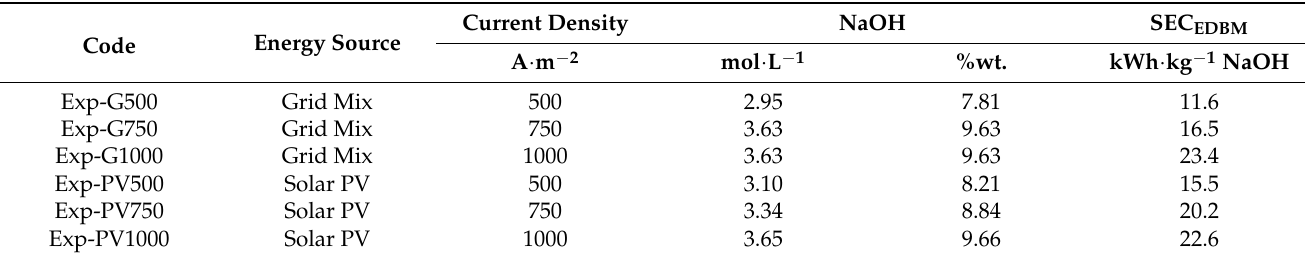
Table 1. Summary of the maximum NaOH concentrations and the SEC EDBM . Adapted from Herrero- Gonzalez et al. [26].